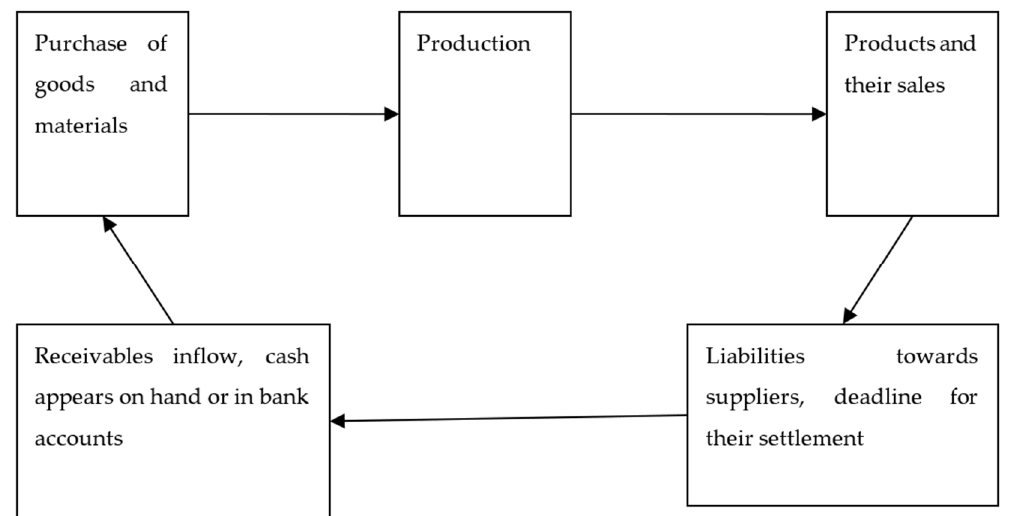
Figure 6. Circulation of working capital.